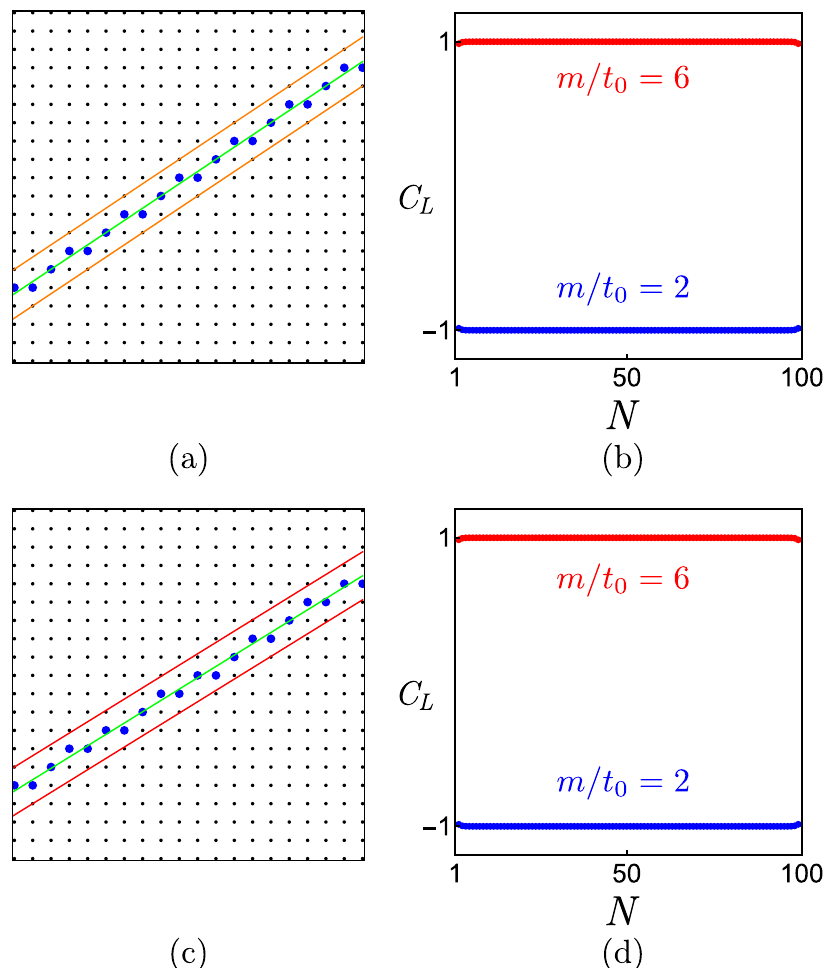
Fig. 5 Topological invariant of projected Chern insulators on 1D branes. a Local Chern number ( C L ) is computed on the blue sites, residing around the green lines, given by y mid = ( y u + y d )/2 when the brane is inclined at a rational slope [Fig. 1]. b The variation of C L along the green line, on which the sites are indexed by N , is shown for m / t 0 = 2 (blue dots) and m / t 0 = 6 (red dots) [Eq. (3)], displaying its quantized values, equal to the Chern number (C) of parent 2D Chern insulator. c and d Are analogous to ( a ) and ( b ), respectively, but when the brane is inclined at an irrational slope. For details see Supplementary Note 1 and Supplementary Fig. 1 of the SI. The results are obtained by constructing the branes from a parent square lattice of linear dimension L = 100 in both x and y direction for x u = 22 and x d = 12, such that they contain ( b ) 10.3% and ( d ) 10.6% of sites of parent square lattice [Fig.